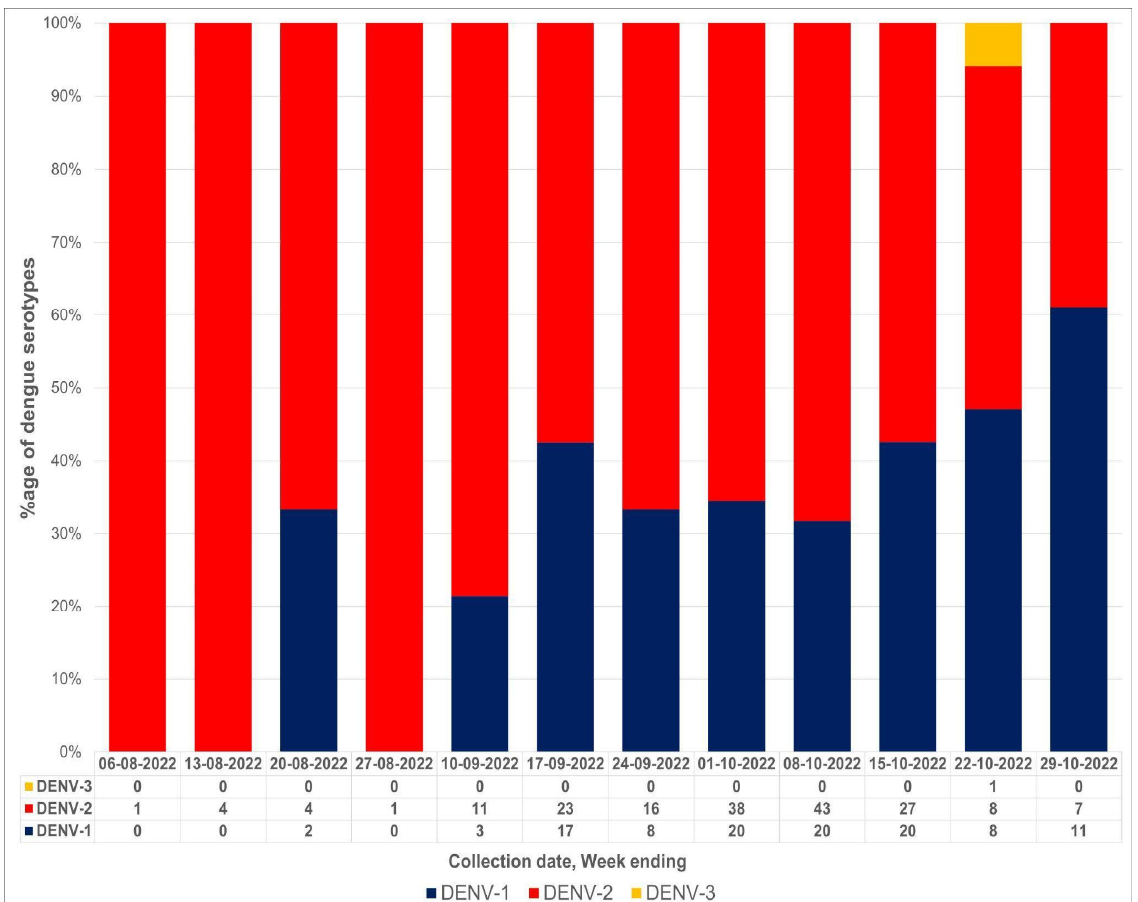
Figure 1. Week-wise distribution of dengue virus serotypes (August–October 2022).